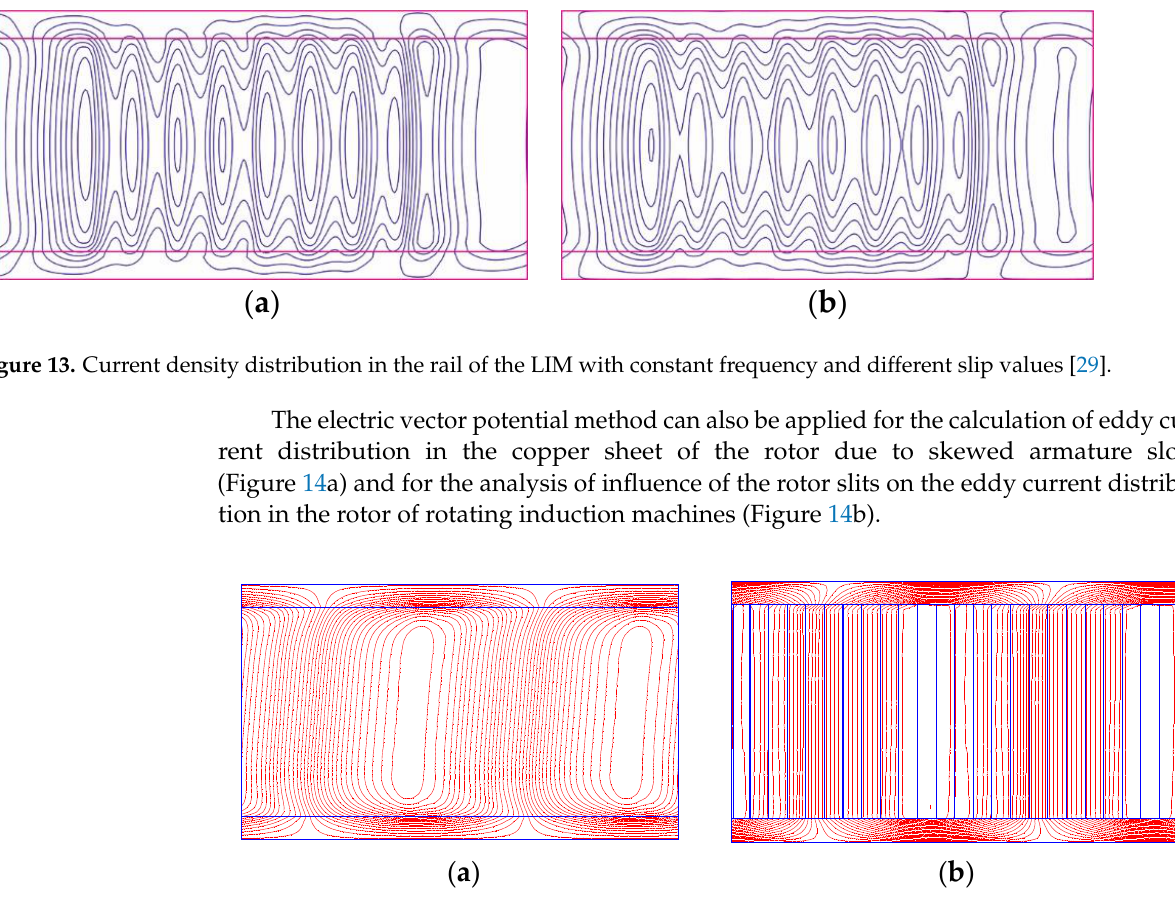
Figure 14. Eddy current distribution in the copper sheet of the rotor due to skewed armature slots ( a ). Influence of the rotor slits on eddy current distribution in the rotor ( b ) [89,90].